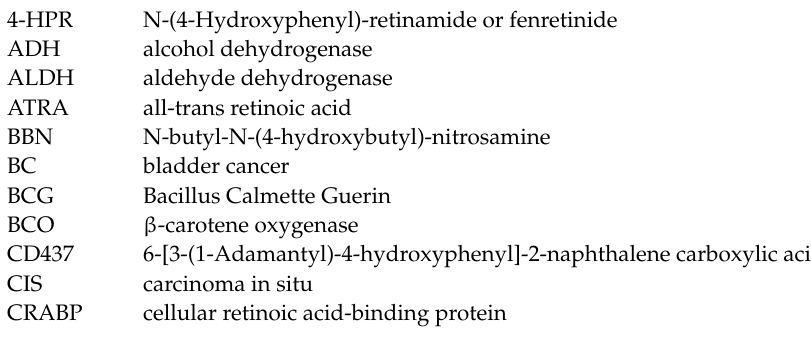
figure preparation—L.T. All authors have read and agreed to the published version of the manuscript. Funding: The authors acknowledge financial support from the P3-0108, P3-0054, J7-2594, J3 2521, MRIC UL IP-0510 Infrastructure program of the Slovenian Research Agency